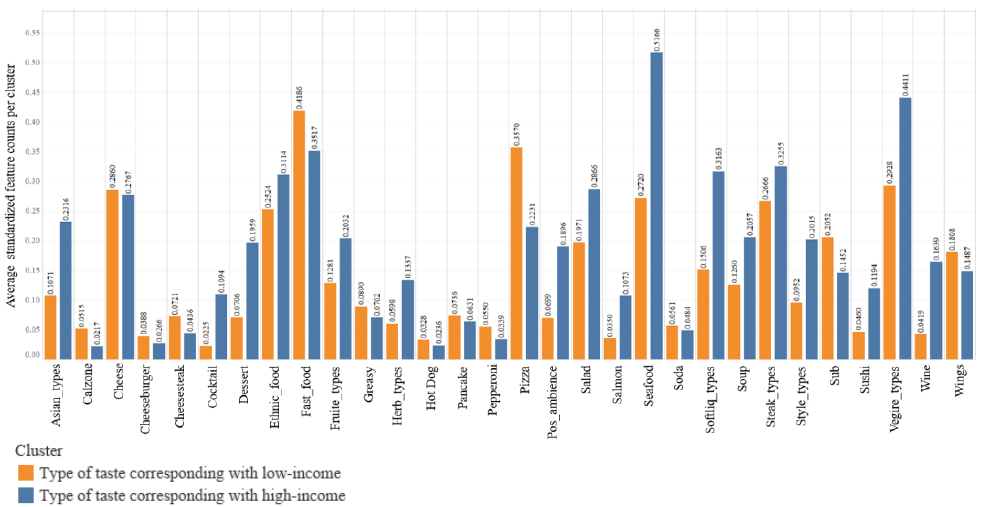
Figure 8. Clustering results overlaid on per capita income map for four cities. As we can see the two clusters clearly correspond with block-group level income per capita map from Census.